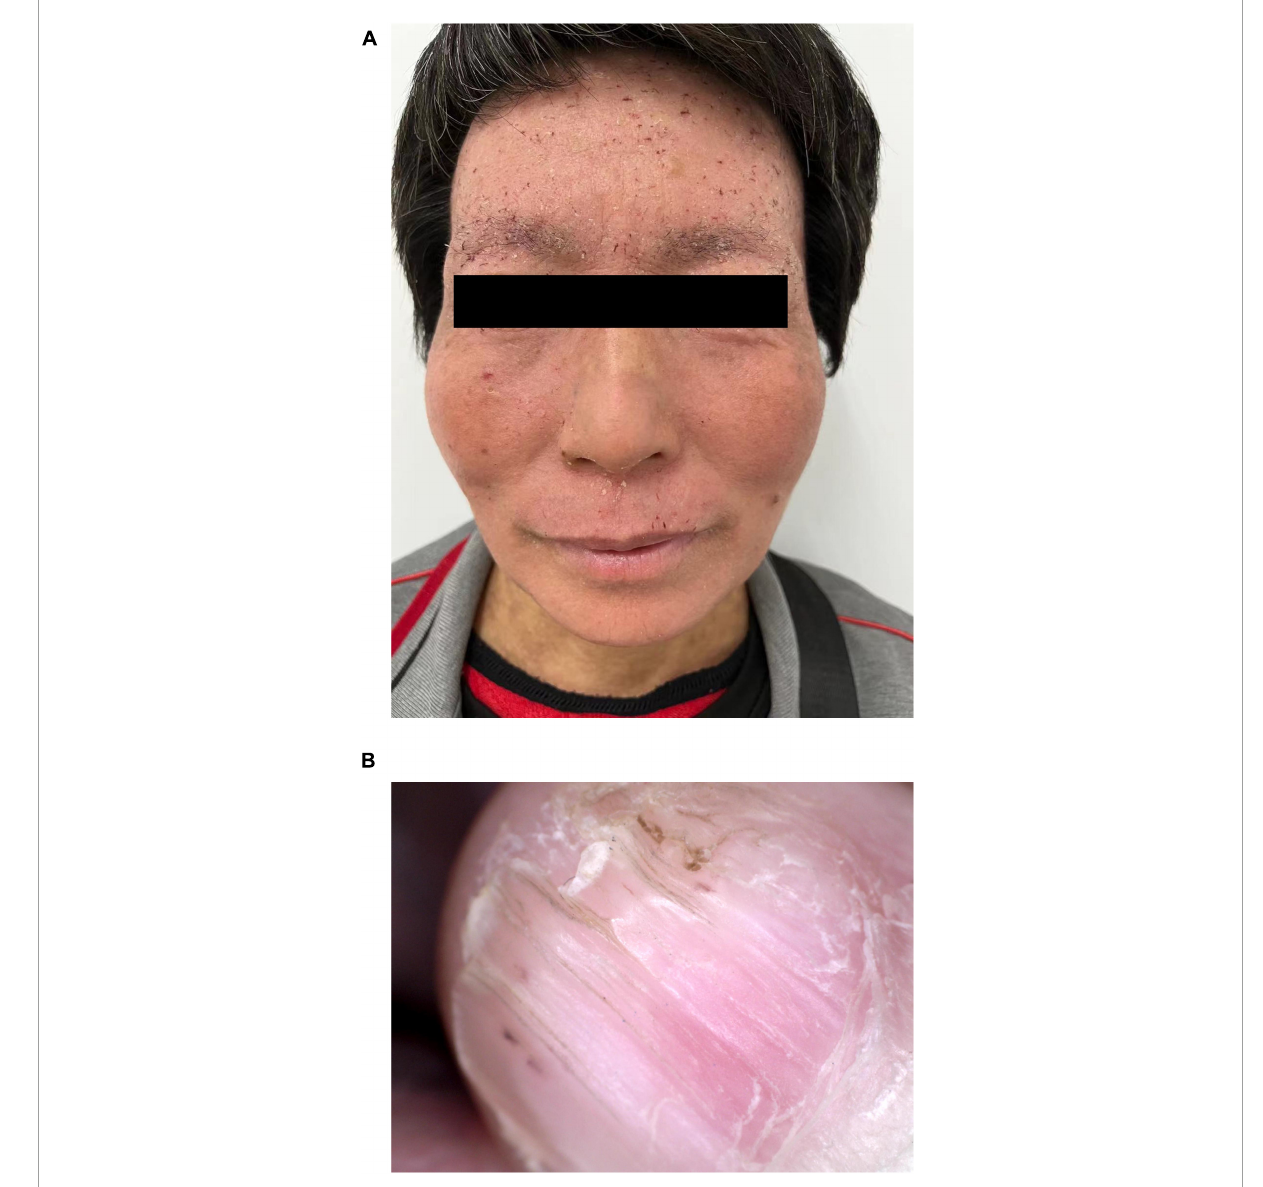
FIGURE4 Clinical pictures of the patient’s mother. (A) Several isolated keratinized papules were seen densely distributed on the face and neck of the patient’s mother. (B) Longitudinal stripes and V-shaped defects were seen on the